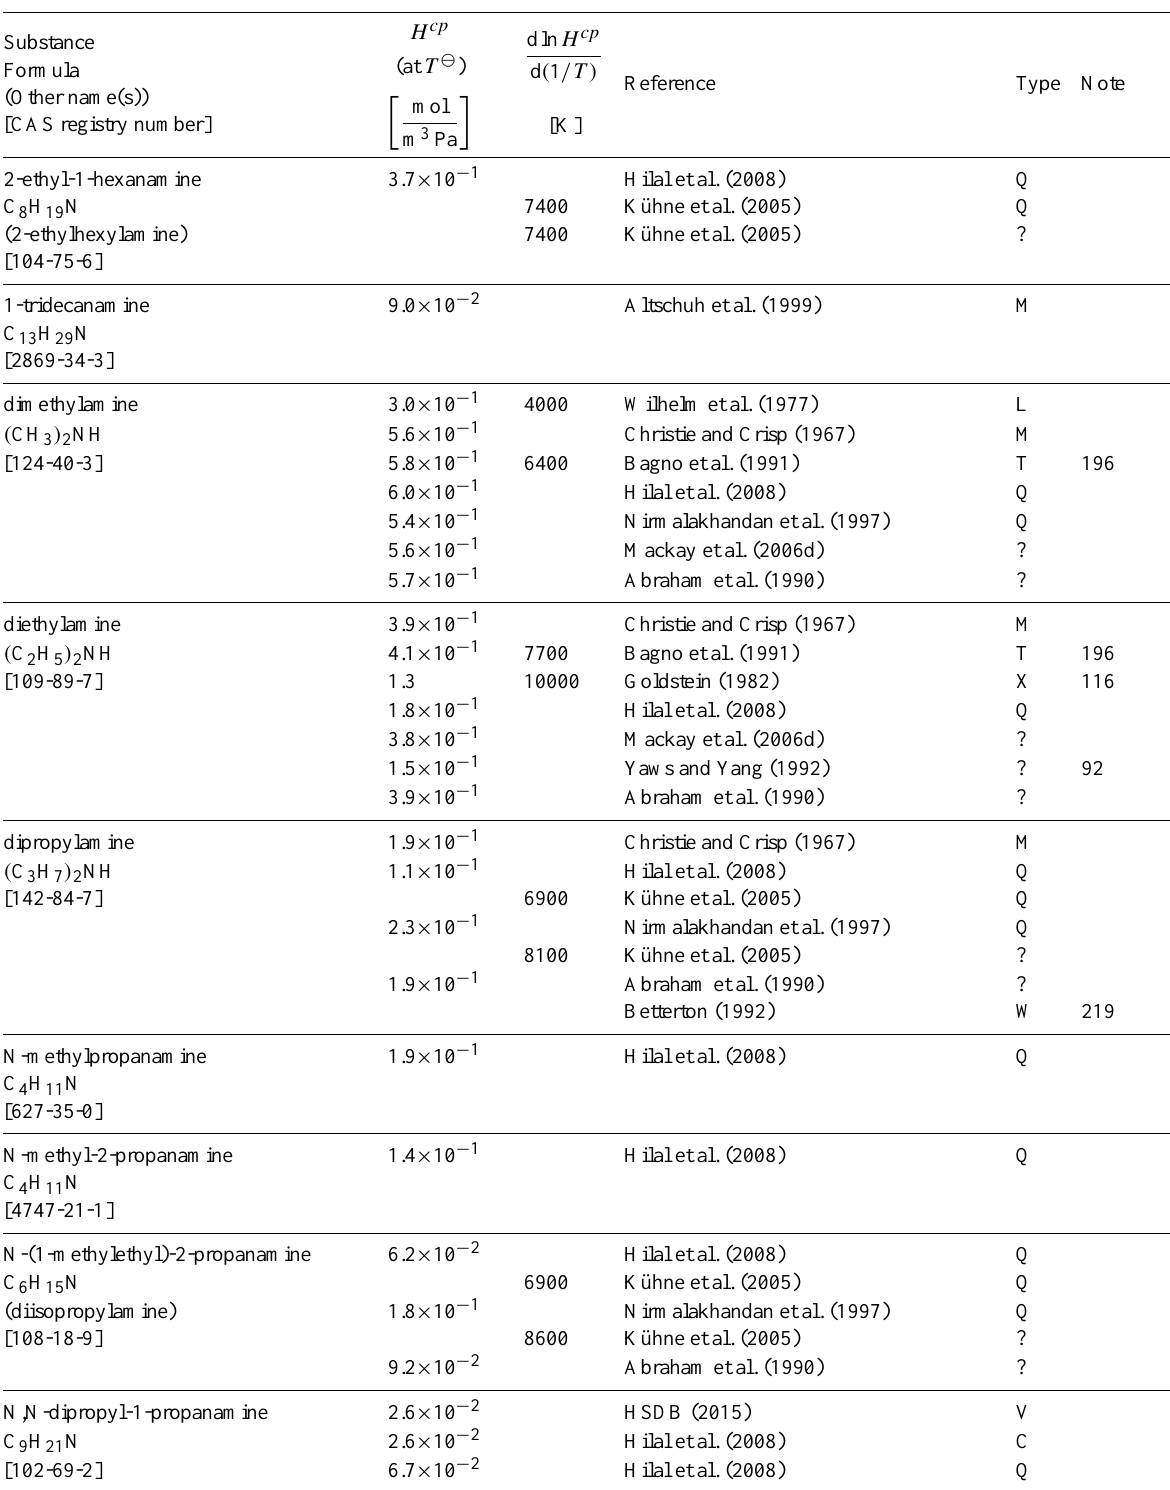
Table 6: Henry’s law constants for water as solvent